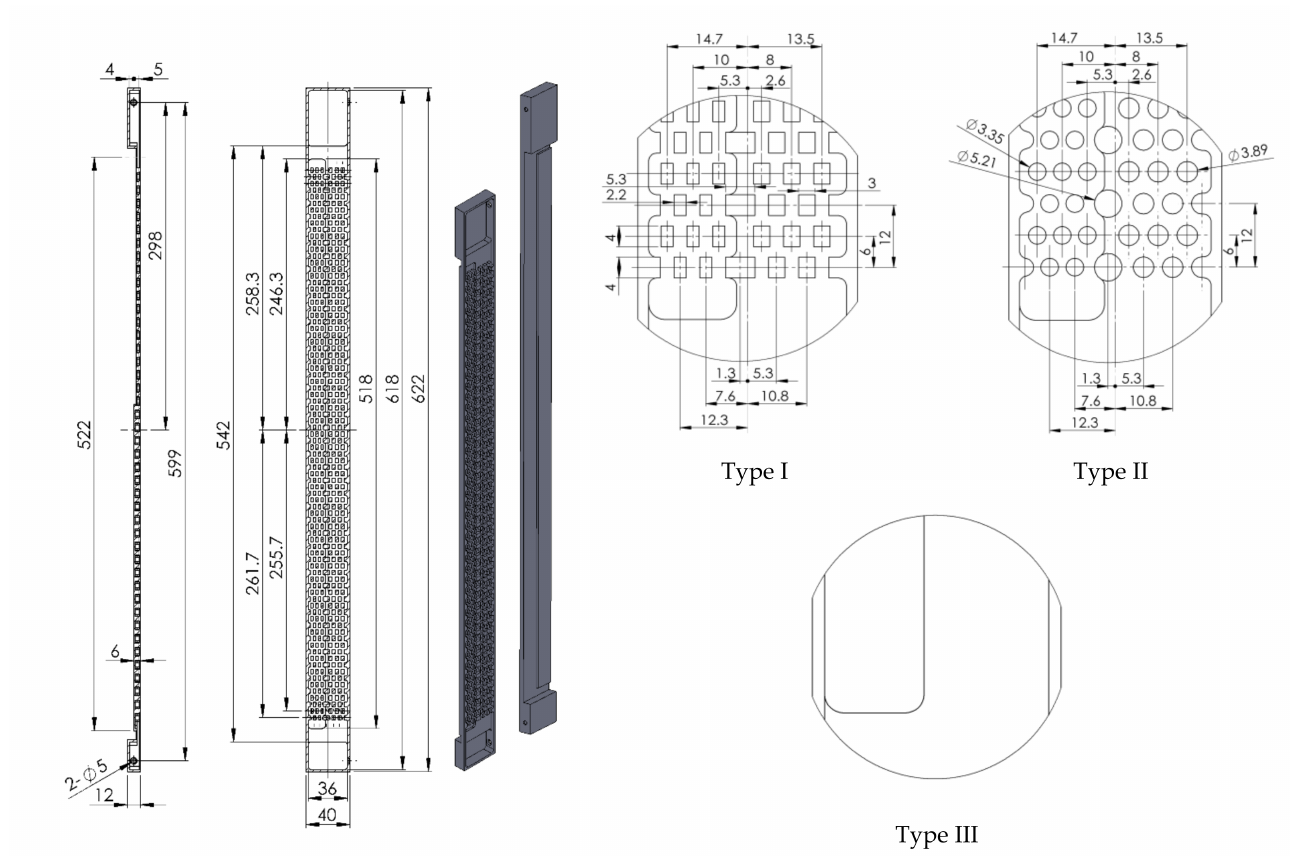
Figure 3. Design drawing of the internal and external configuration of a three-dimensional cold